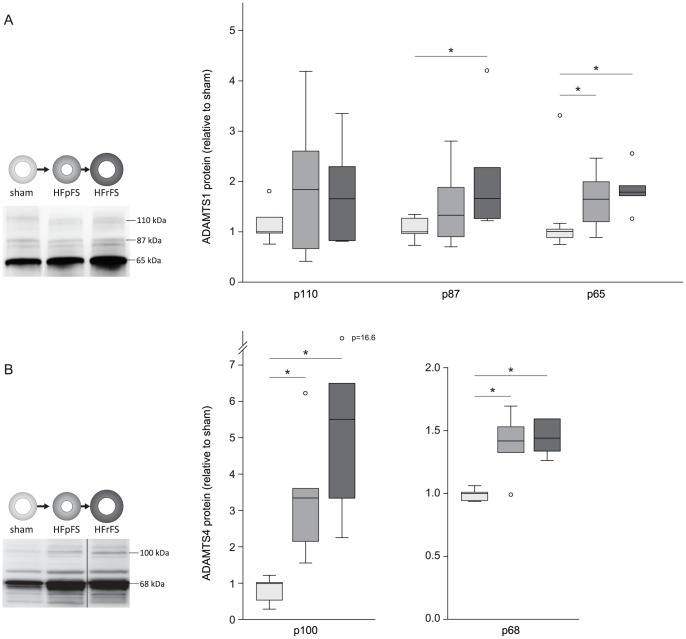
Increased protein expression of ADAMTS1 and -4 after aortic banding.Myocardial protein expression of ADAMTS1 (A) and -4 (B) in rats with preserved (HFpFS, n = 9) or reduced FS (HFrFS, n = 6) six weeks after aortic banding. Box-plots show median (horizontal line), interquartile range (box), 1.5xinterquartile range or maximum/minimum range (whiskers) and outliers (>1.5xinterquartile range). *p<0.05. AB, aortic banding; FS, fractional shortening.